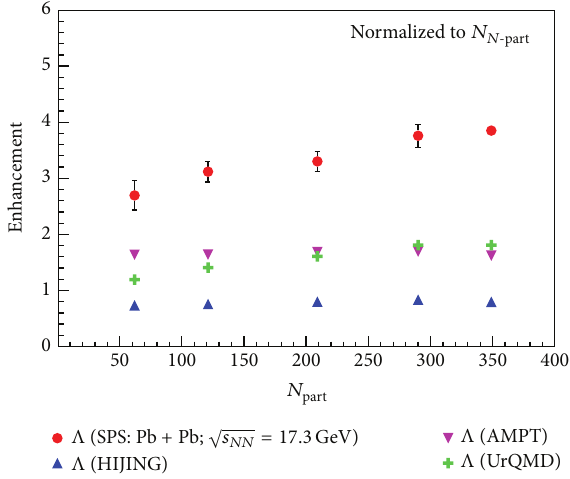
Figure 3: 𝑁 𝑁 -normalized enhancements of Ω + Ω as a function -part of collision centrality for Au + Au collisions at √𝑠 𝑁𝑁 = 200 GeV are compared with HIJING, AMPT, and UrQMD models at midrapid- ity.